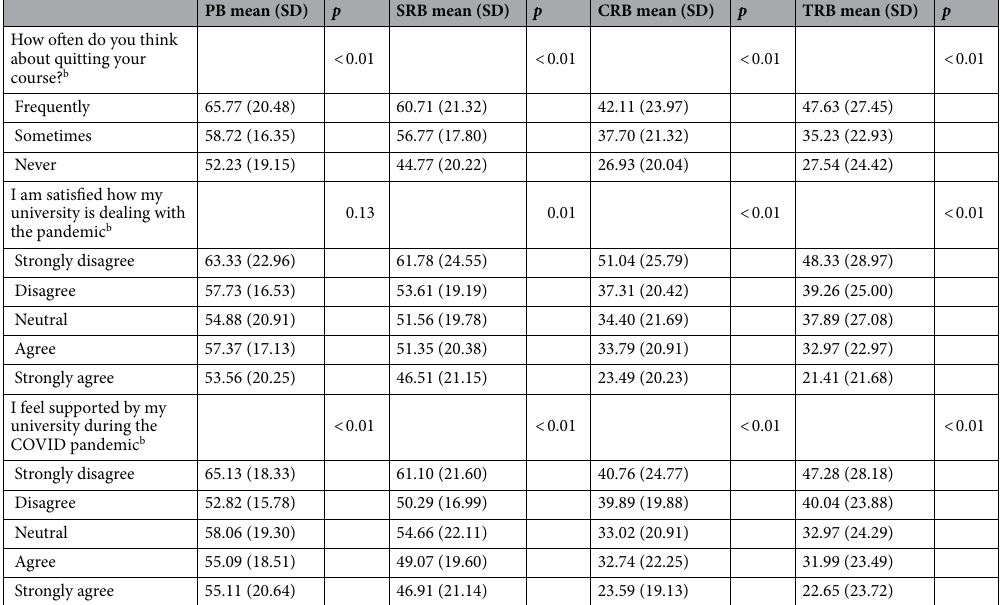
Table 3. Comparison of the average of the CBI dimensions according to academic characteristics. b ANOVA.